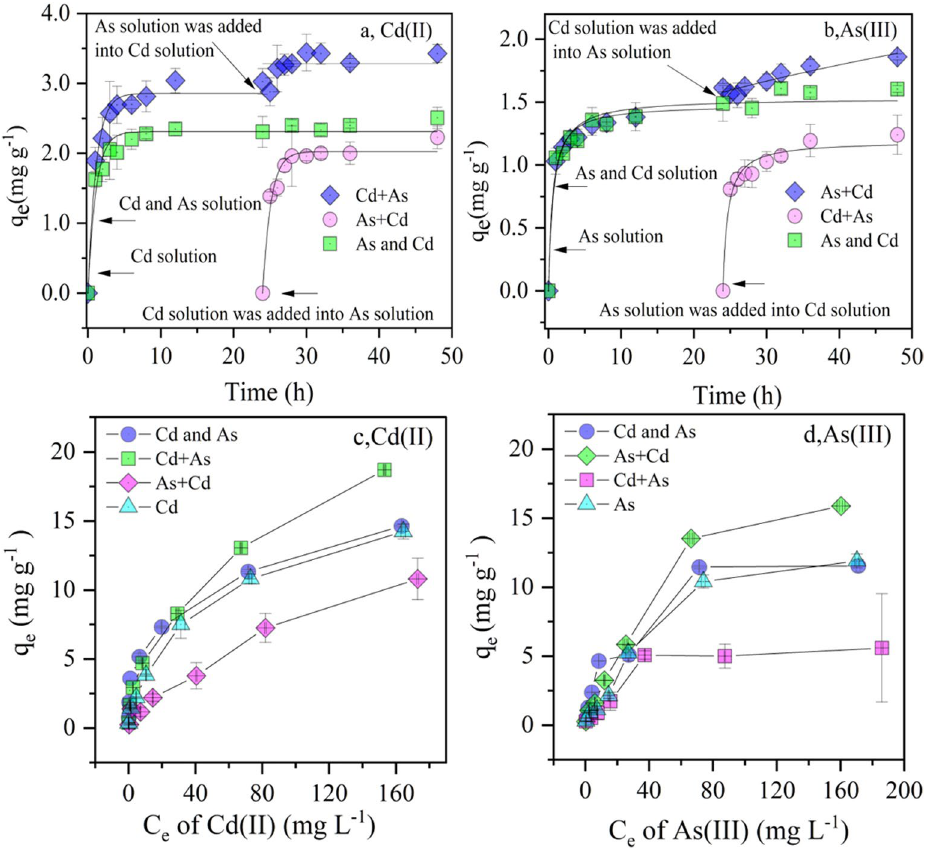
Figure 1. Adsorption kinetics ( a,b ) and isotherm ( c,d ) of As (III) and Cd(II) on Fh@BC in the single or binary solution with pH 7.0 ± 0.1 at 25 ℃ .